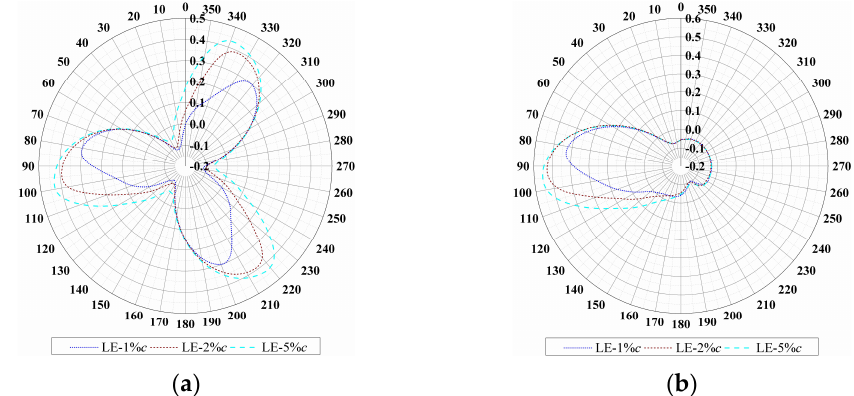
Figure 10. Variation of C m with respect to θ during one rotational period at TSR = 1.5 for ( a ) the rotor; ( b ) blade 1.